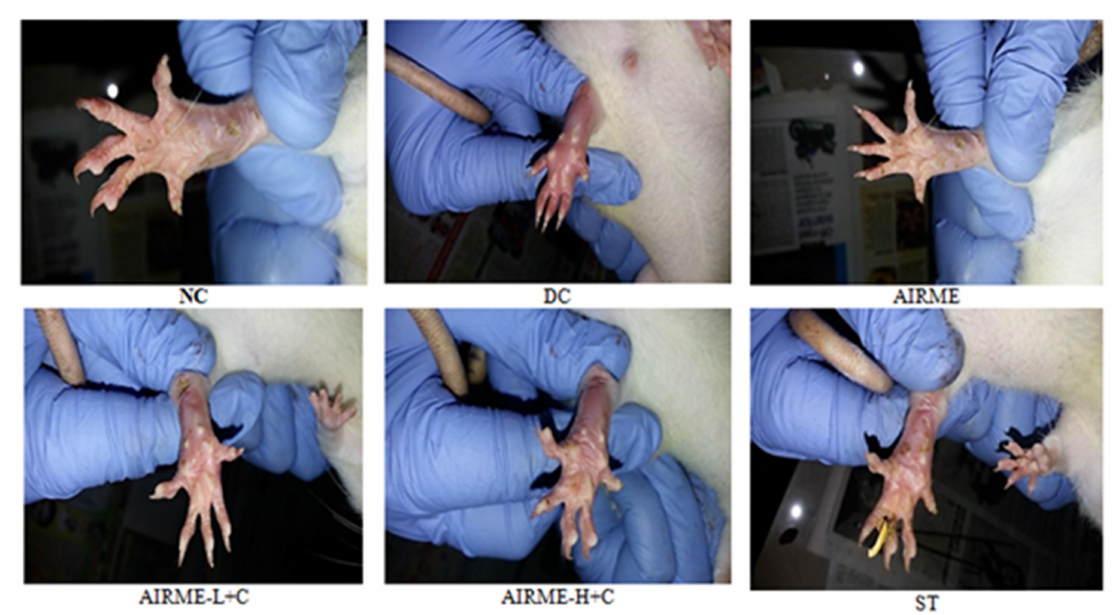
Figure 2. Physiological changes in rat paw tissue following carrageenan injection (1%) in different groups with or without AIRME 150. mg/kg), AIRME-H+C (300 mg/kg) and diclofenac (ST) pretreated rats. NC, normal control; DC, disease control; AIRME, A. indica root methanolic extract; AIRME-L+C, AIRME-low-dose plus carrageenan; AIRME-H+C, AIRME-high-dose plus carrageenan; ST, standard treatment.